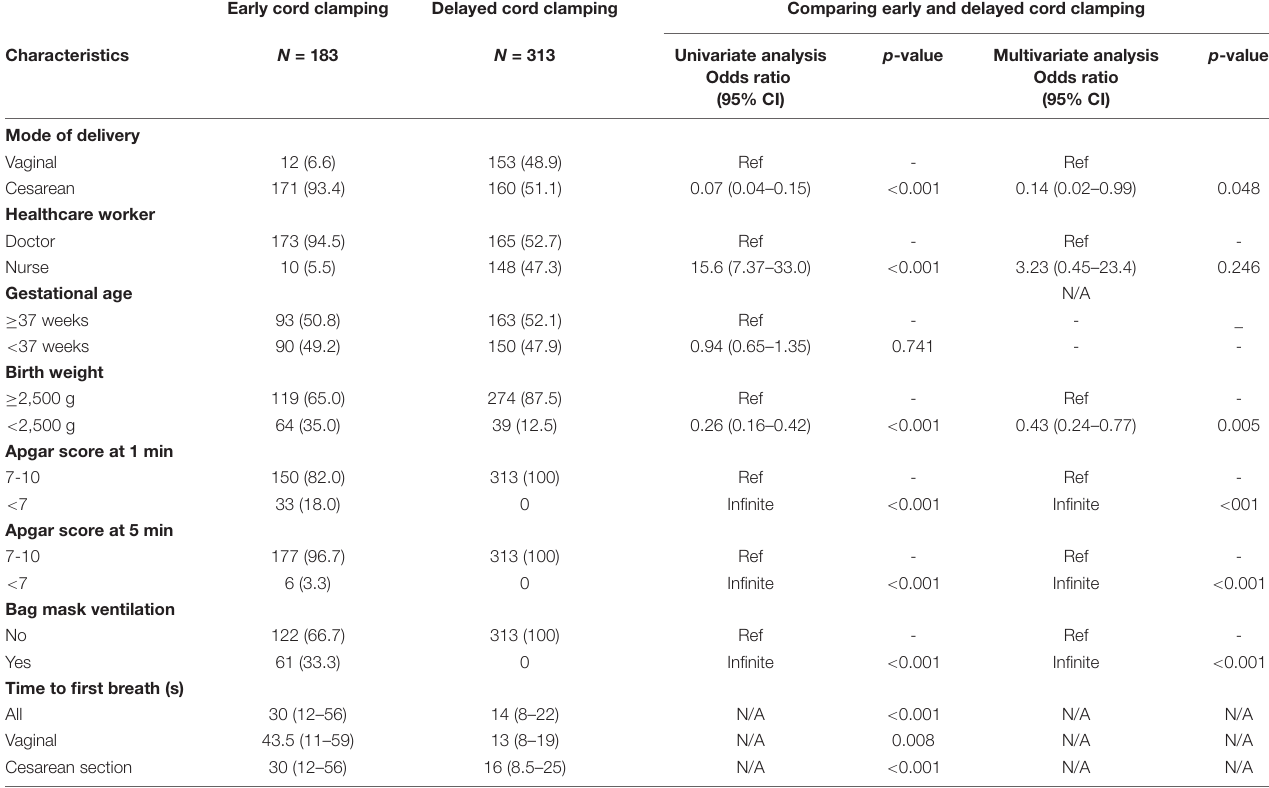
TABLE 5 | Comparing characteristics of deliveries with early ( < 60 s) vs. delayed ( ≥ 60 s) cord clamping. Early cord clamping Delayed cord clamping Comparing early and delayed cord